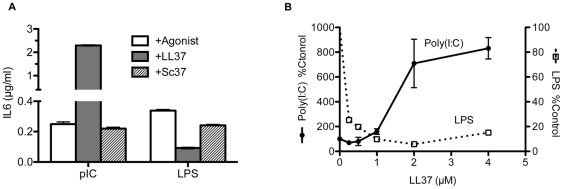
Effects of LL37 on cytokine production by BEAS2B cells.A) LL37 can enhance IL6 production in response to dsRNA and repress IL6 levels in response to LPS. Cells were stimulated with agonists ± LL37 or scrambled LL37 (Sc37). After 20 h, the culture media were collected. An aliquot of the media was assessed for secreted IL6 using a human IL6 ELISA assay and the amount of IL6 normalized to total volume. The final concentrations of LL37, Sc37, poly(I:C) and LPS were 2.2 µM, 2.2 µM, 0.13 µg/ml and 1 µg/ml, respectively. LL37 enhanced poly(I:C) induced IL6 production (p<0.0001;) while Sc37 had no effect (p = 0.2). B) Dose-dependent effects of LL37 on poly(I:C)-induced and LPS-induced IL6 levels. Culture media were harvested 20 h after the addition of ligands and proteins. Each sample was performed in duplicate or triplicate and data plotted as mean ± SEM.